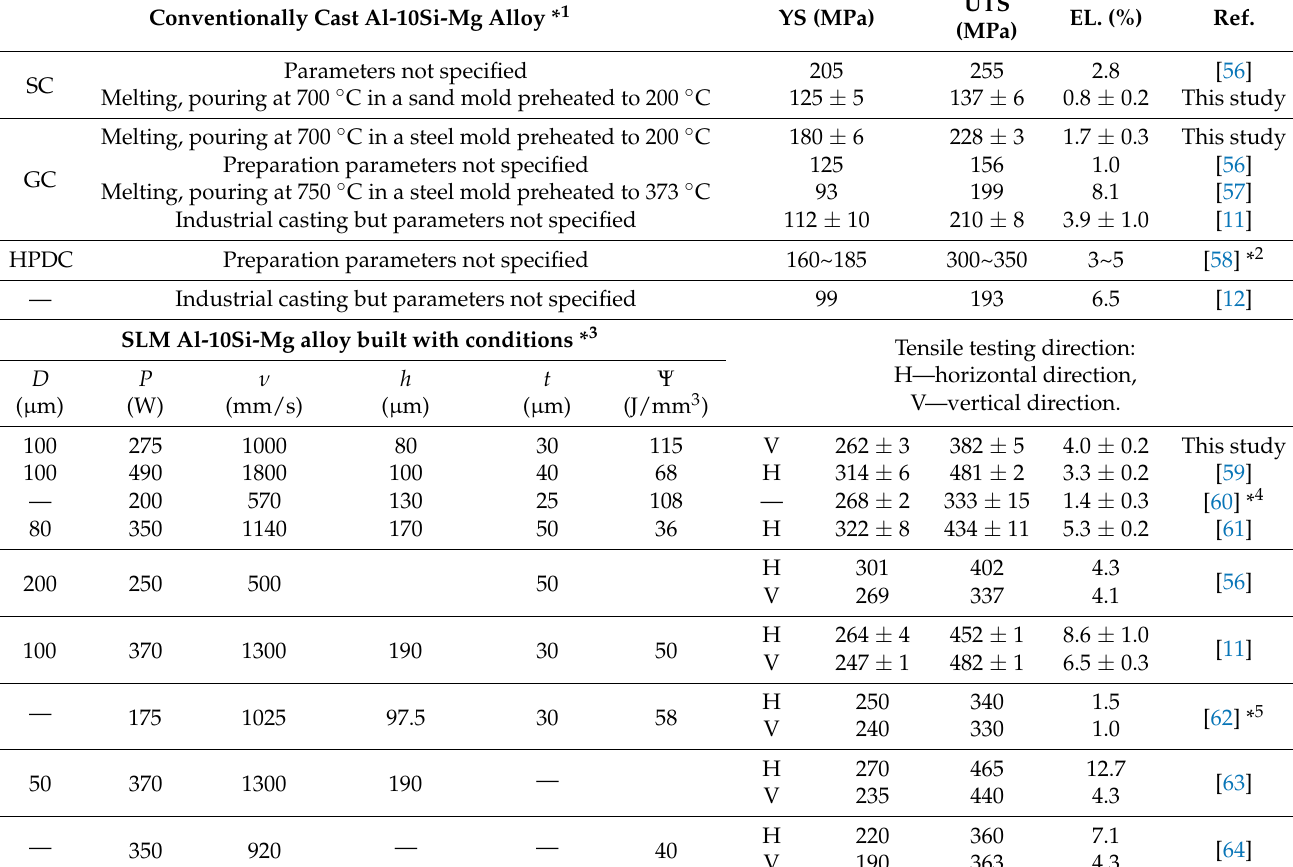
Table 2. Tensile mechanical properties of conventionally cast and as-built SLM Al-10Si-Mg alloys summarized from some references (without heat